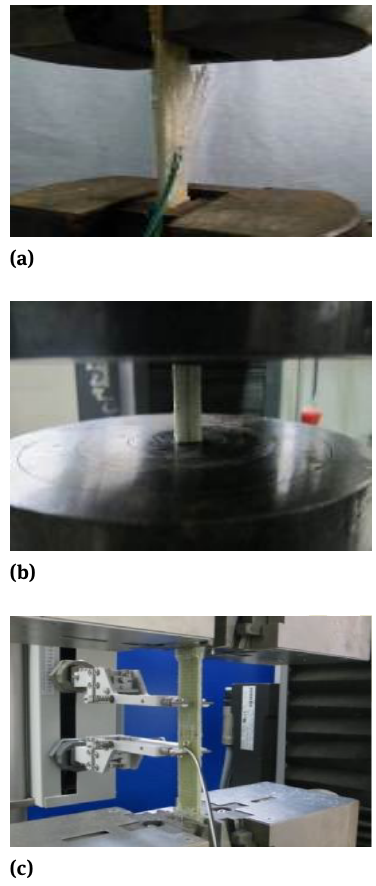
Figure 4: GFRP material test set-up: (a) tensile test (b) compressive test (c) shear